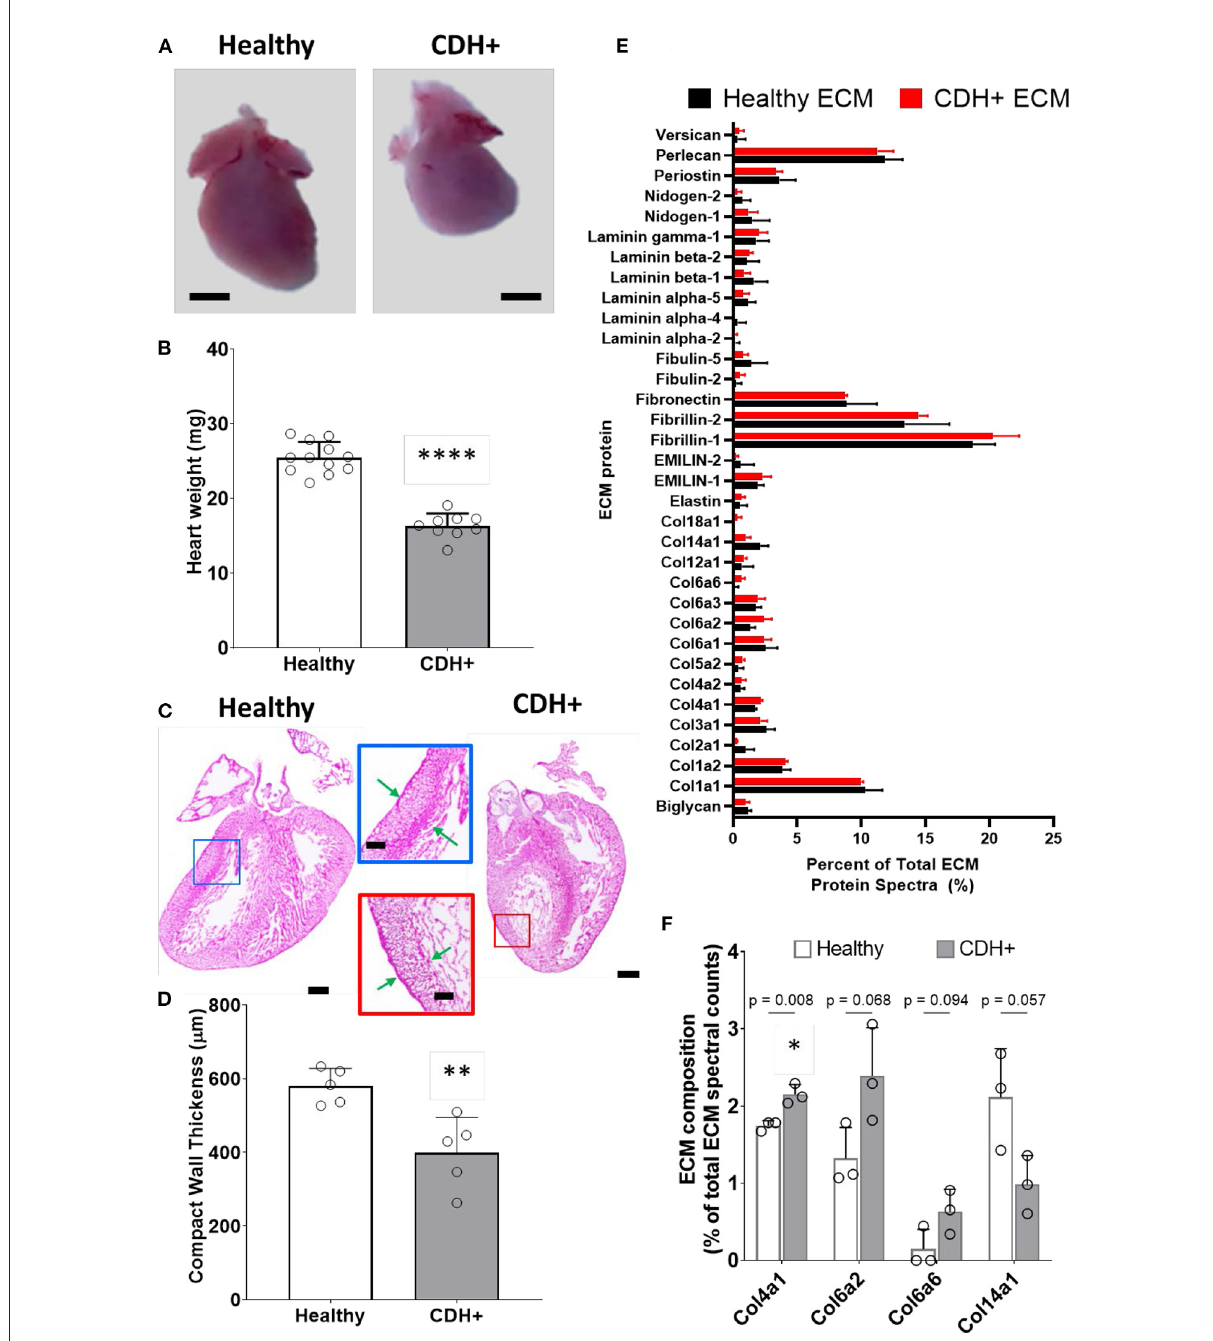
FIGURE1 Altered heart morphology in the rat model of CDH. (A) Representative images of E21 hearts from healthy controls and nitrofen-treated CDH + fetuses. Scale bar represents 1mm. (B) Heart mass measurements (mean ± S.D.). **** Denotes p < 0.0001 from unpaired t-test. (C) Representative H&E stained sections of healthy and CDH + hearts. Insets show measurements of LV compacted free wall thickness (green arrows). Scale bars = 500 µ m for whole heart sections and 200 µ m for insets. (D) Measurements of left ventricle (LV) free wall thickness ( n = 5) (mean ± S.D.). ** Denotes p < 0.01 from unpaired t-test. (E) All proteins detected during LC-MS/MS proteomics analysis of healthy and CDH + heart ECM. Data are presented as the percent of total ECM protein spectra (mean ± S.D.). (F) Data for proteins that are significantly different or close to it between healthy and CDH + hearts. p -values for each comparison between healthy and CDH + hearts using an unpaired t-test are shown above the grouped bars. Again, data is presented as percent of total ECM protein